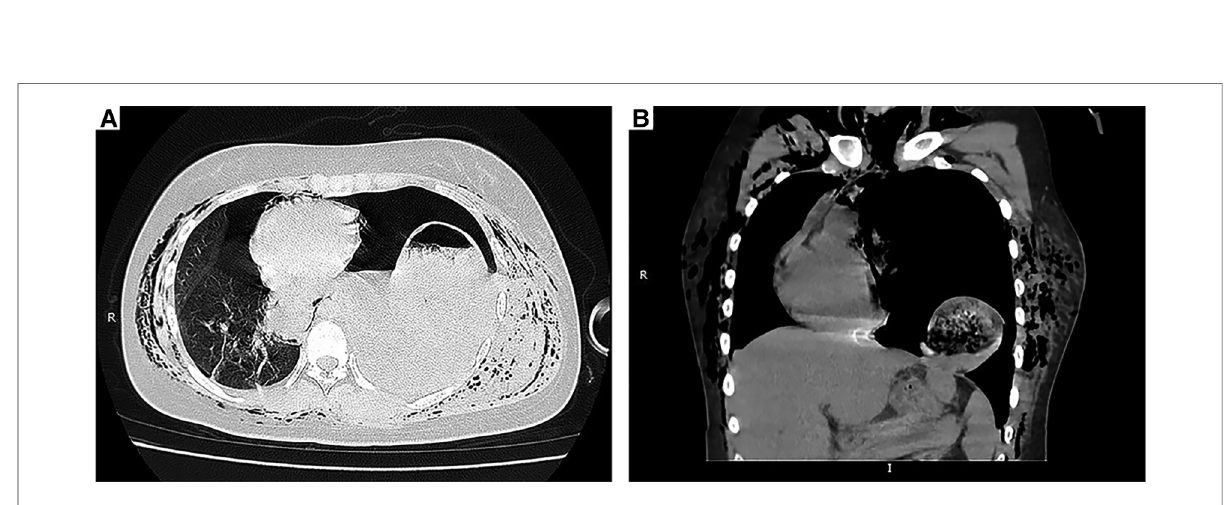
FIGURE 2 CT scans. ( A ) Preoperative chest CT image showed left pleural effusion, collapsed lung and intragastric gas with an air- fl uid level in the left thoracic cavity. ( B ) Coronal CT image demonstrating that the stomach had migrated into the